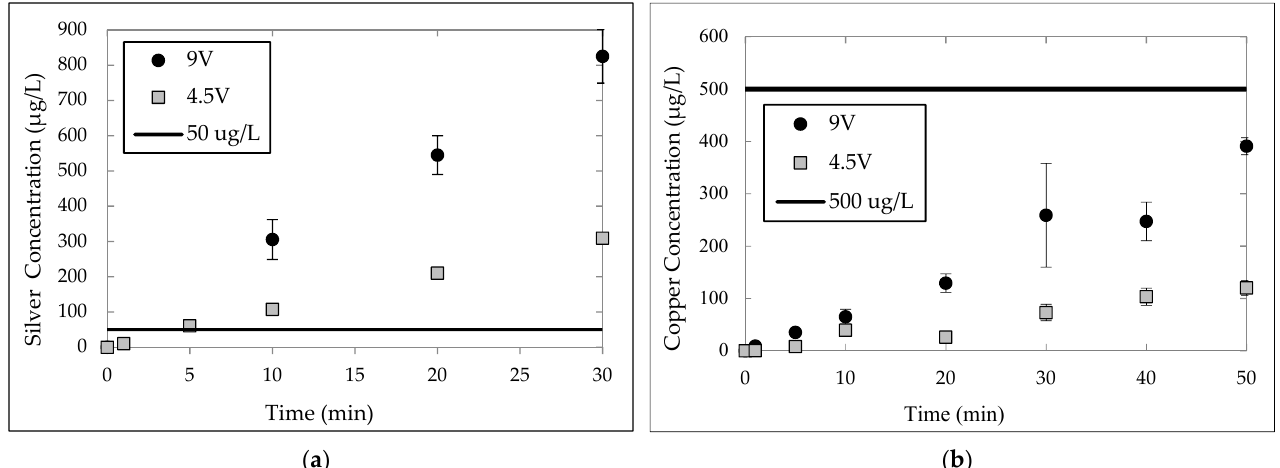
Figure 9. Metal ion concentration as a function of time in 10 L synthetic groundwater with applied voltages of 4.5 V and 9 V via a DC current. The ionic strength of the synthetic groundwater was 4.58 × 10 − 3 M . ( a ) displays ion release for an apparatus with 1 mm silver wire, and ( b ) displays release for the same apparatus with copper wire. The target concentration for silver and copper is indicated by a horizontal line in each figure. The error bars extending from each average measured concentration represent the standard error between trials. A trendline is included for each voltage to depict the linear relationship between metal ion release and time. In the design of a prototype, it was determined that 4.5 V be applied via a DC current for 5 min to release 50 µg/L of silver. Similarly, it was determined that 9 V applied via a DC current for 68 min would release 500 µg/L copper.